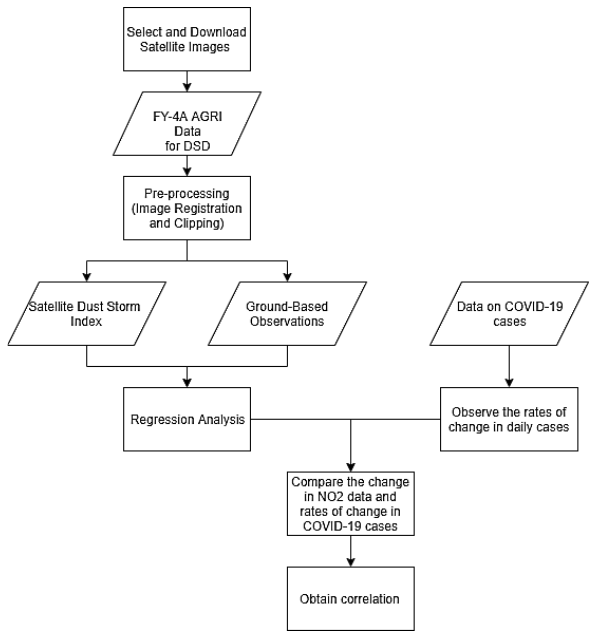
Figure 1. Flowchart of the general methodology of this study.